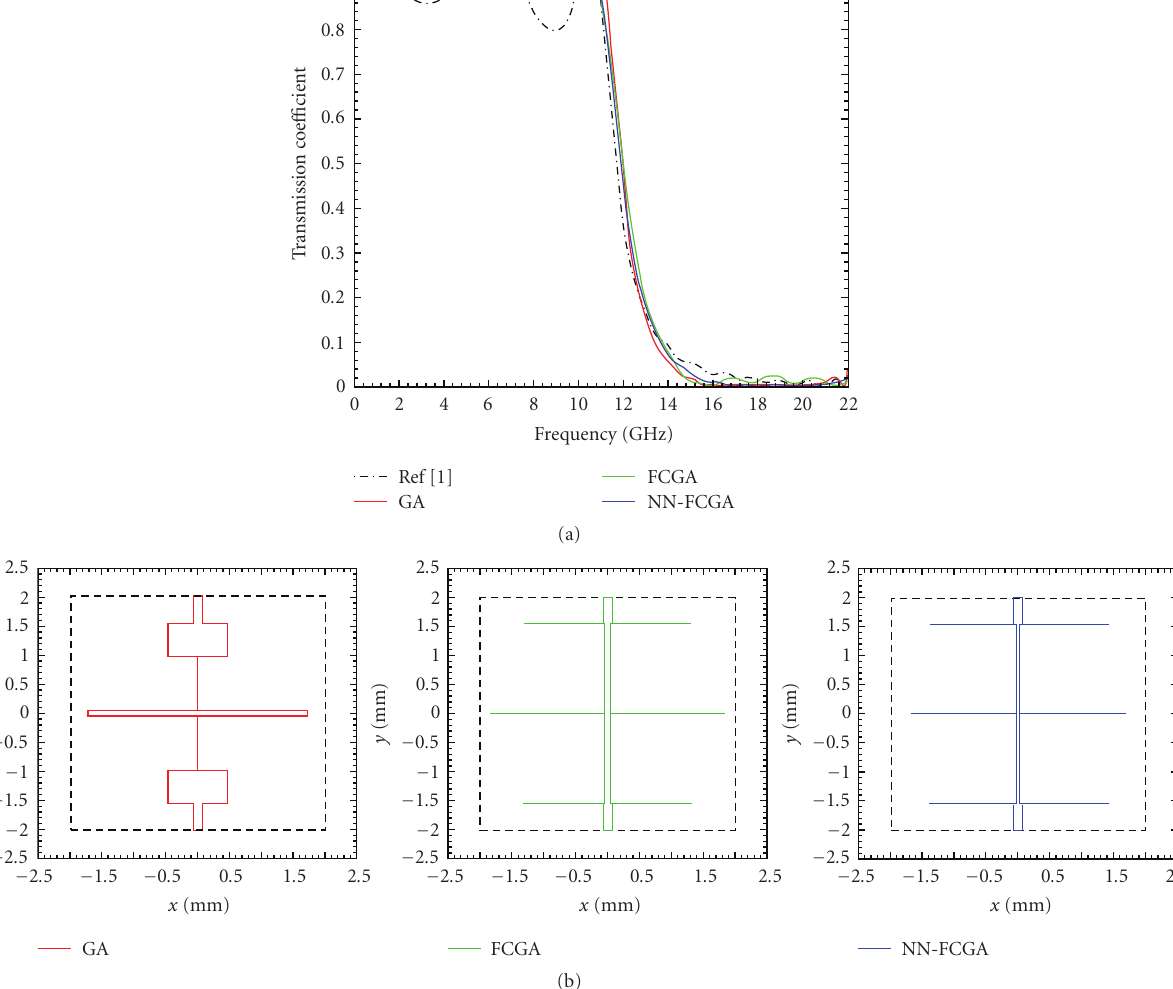
Figure 5: (a)Transmission coe ffi cient versus frequency for the GA (red line), FCGA (green line), and NN-FCGA (blue line). (b) Optimized shapes for the GA, FCGA, and